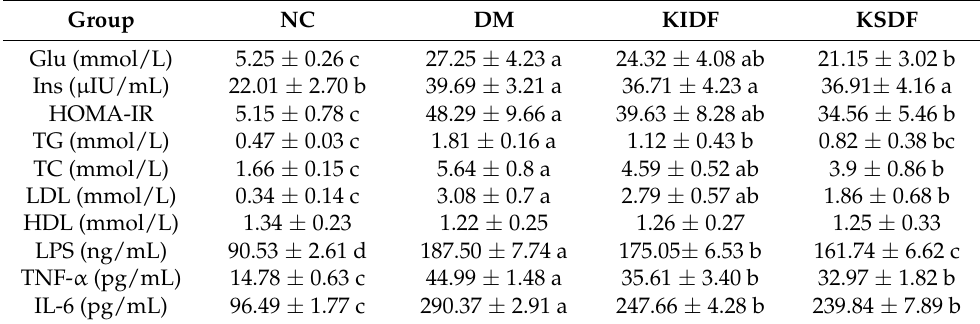
Table 1. The effects of KIDF and KSDF on blood biochemical parameters.